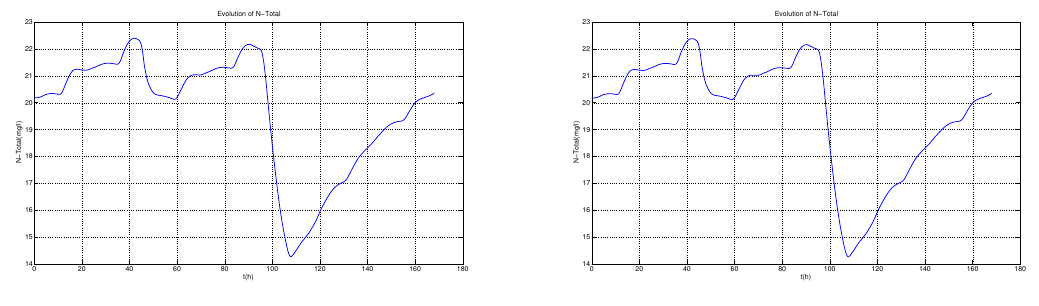
Figure 9. Evolution of N − total : (left) case1; (right) case 2.